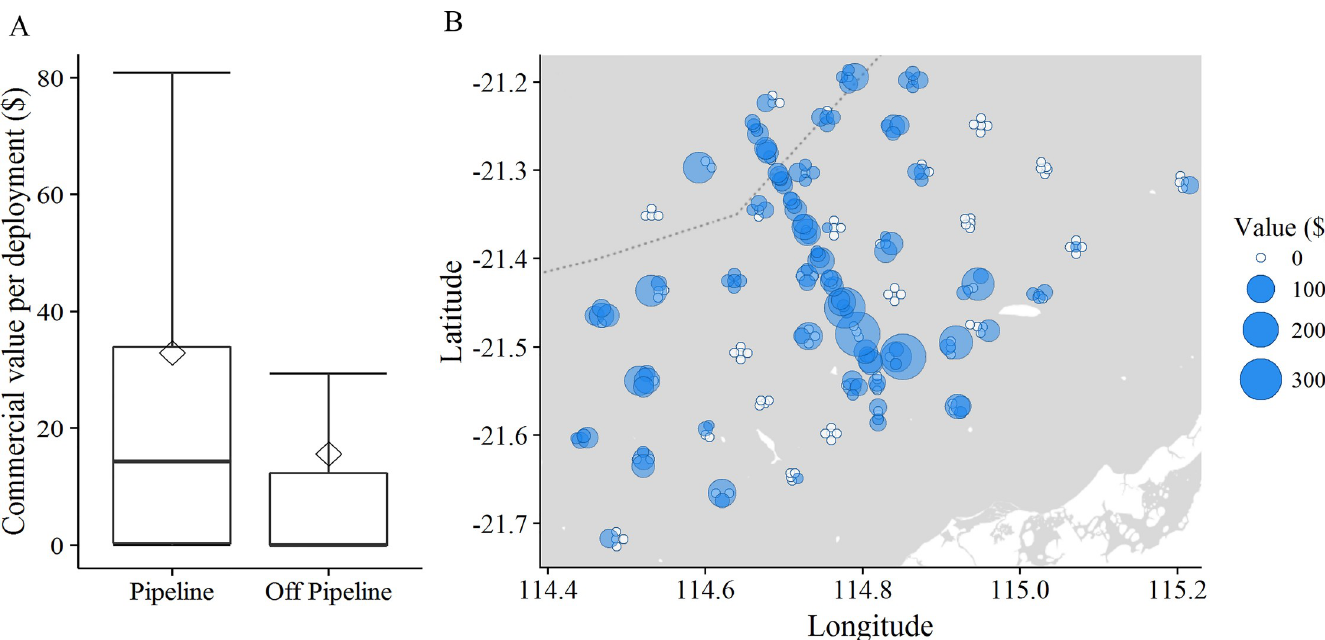
Fig 12. Catch value of commercial species on and off-pipeline. A) Comparisons of the mean ( ^ ) and median (-) catch value recorded on the pipeline and off-pipeline (F(1, 246) = 6.037, p = 0.014). The boxplot show the 95% confidence intervals for the medians, and ranges. B) Spatial distribution of the value of fish recorded in video from each stereo-BRUV